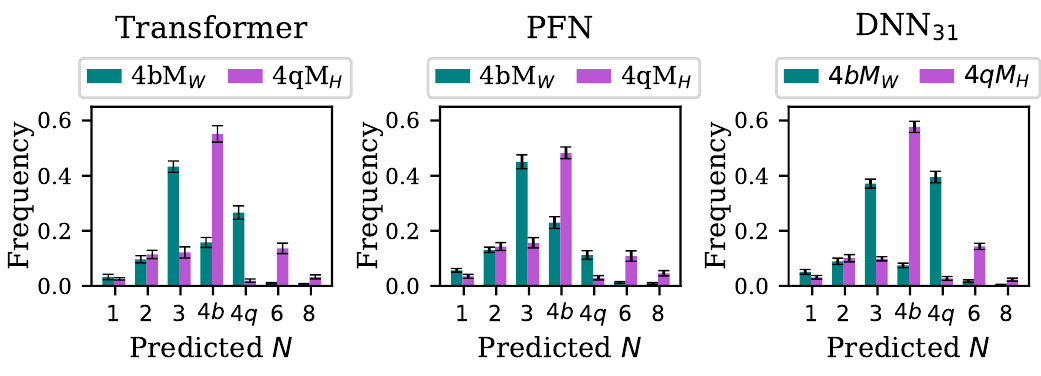
Figure 17 . Frequency of class identification on samples with modified topology ( 4 bM W and 4 qM H ) for networks trained with the standard topologies ( N = 1 , 2 , 3 , 4 b, 4 q, 6 , 8